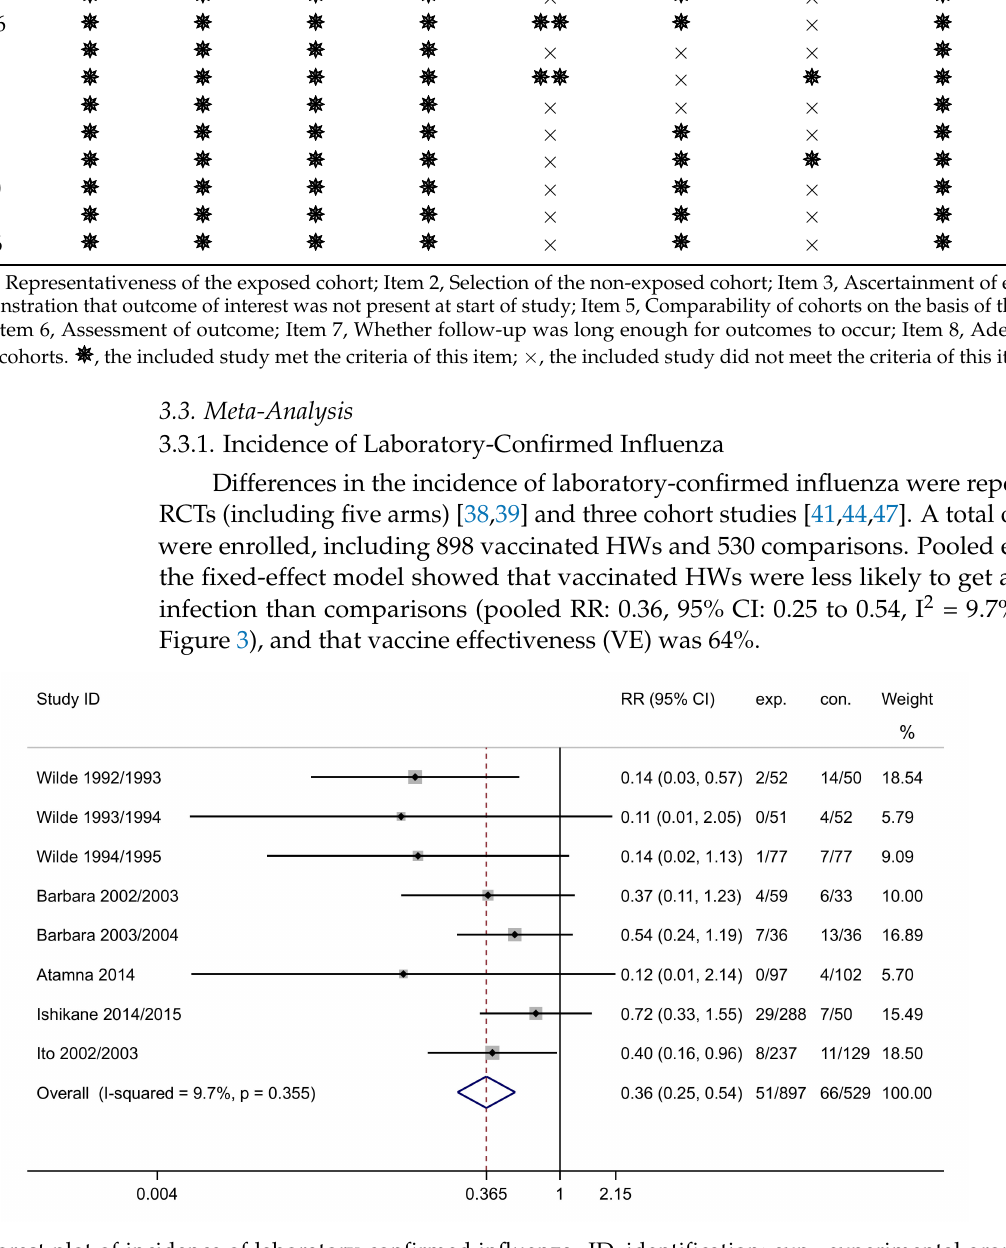
Figure 2. Quality assessment of the six randomized controlled trials. ID, identification.